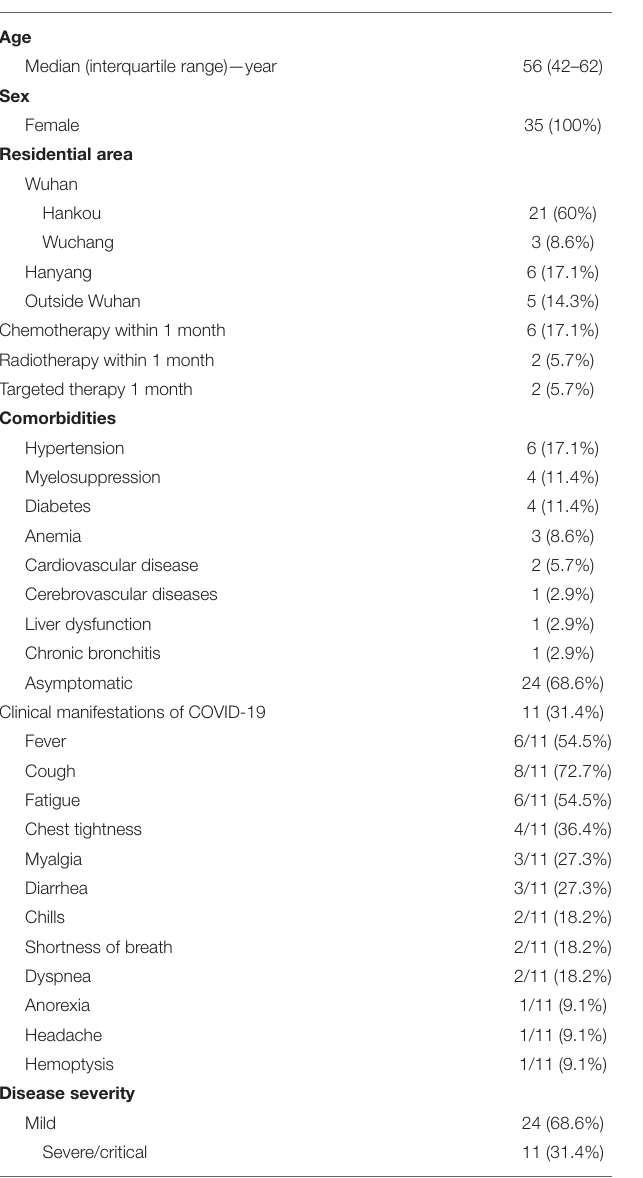
TABLE 1 | Demographics and baseline characteristics of 35 breast cancer patients with COVID-19. Characteristics